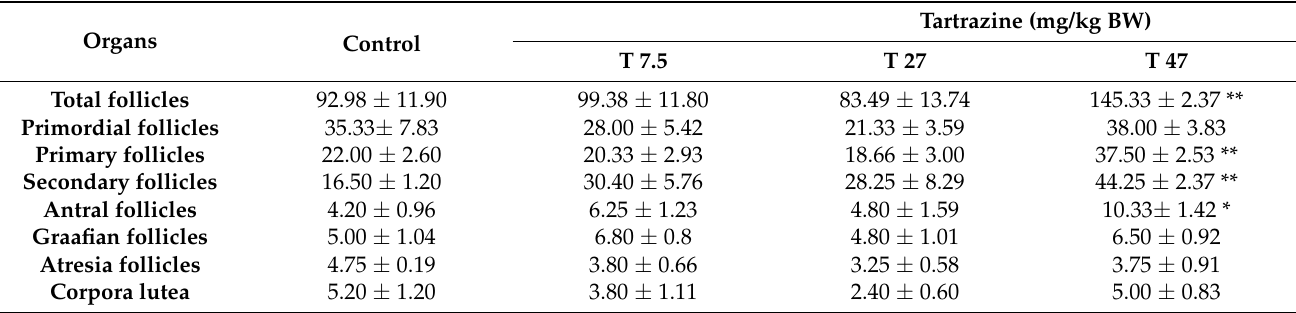
Table 1. Number of different ovarian follicles and corpora lutea of immature female Wistar rats after 40 days of treatment.